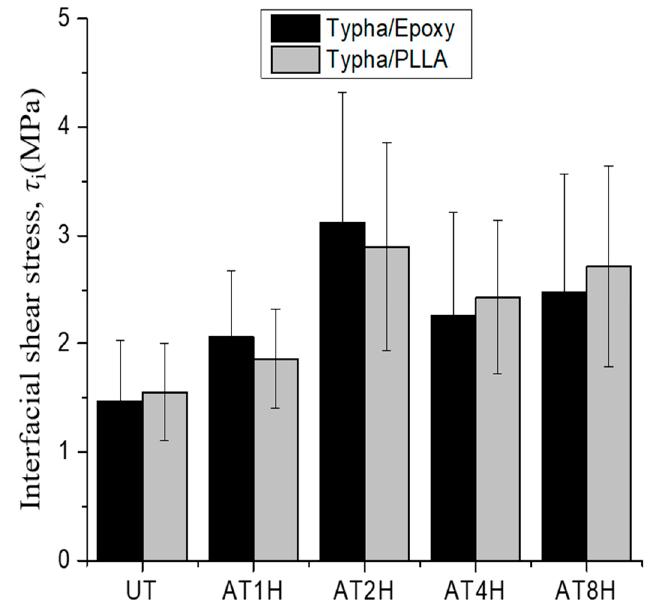
Figure 15. The comparison of the mean interfacial shear strength of Typha spp. /PLLA and Typha spp.